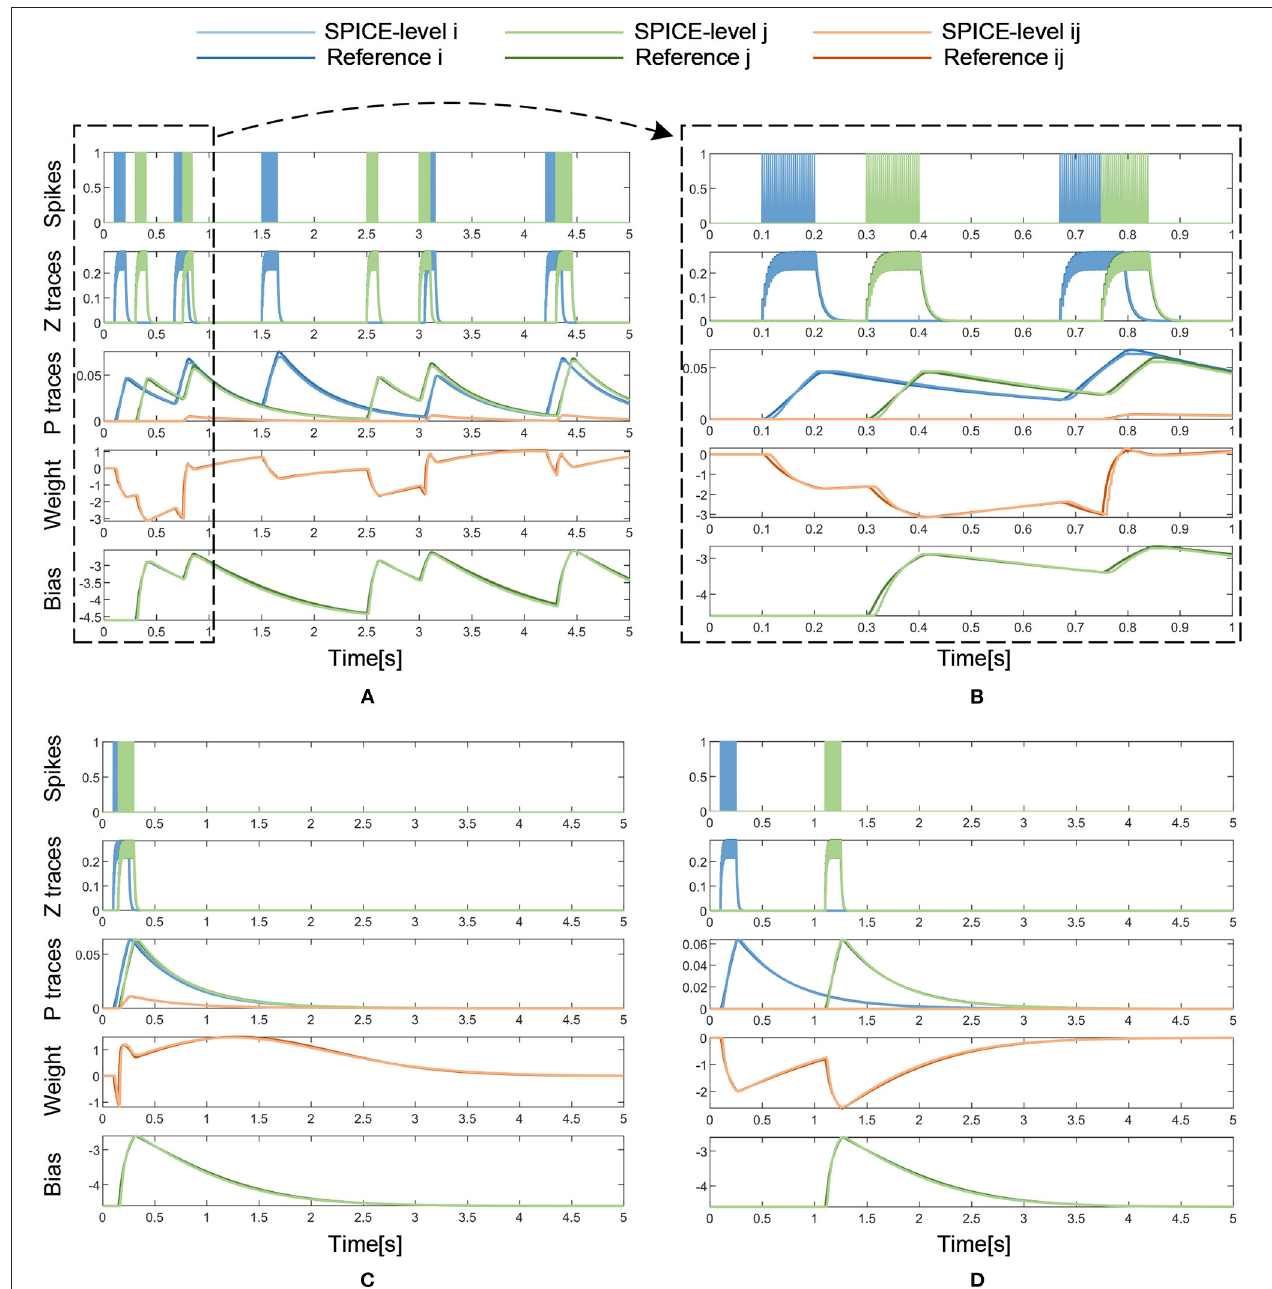
FIGURE 10 | Analog circuit implementation results with dense or sparse incoming spikes. (A) Dense Spikes: 5-s simulation. (B) Dense Spikes: 1-s simulation. (C) Sparse Spikes: presynaptic spike train S i overlaps with postsynaptic spike train S j . (D) Sparse Spikes: presynaptic spike train S i is seperated with postsynaptic spike train S j